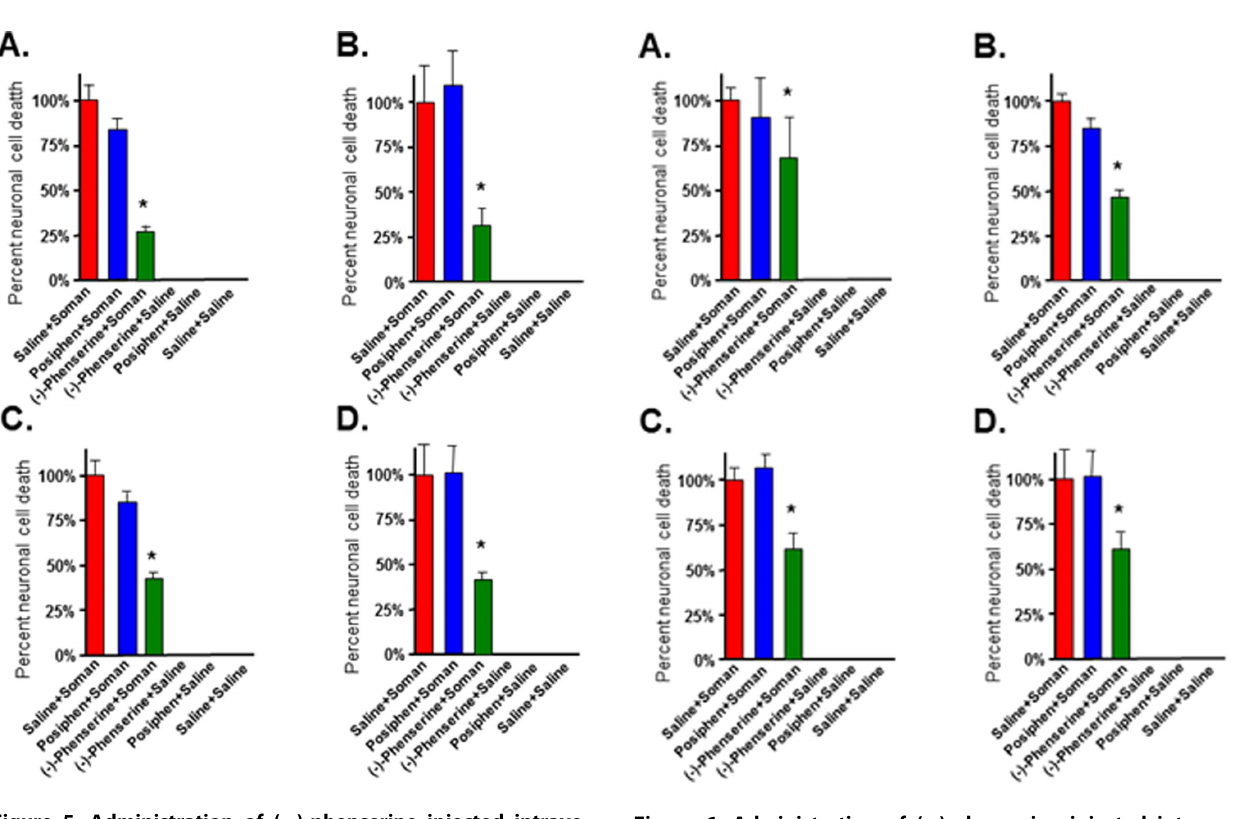
Figure 6. Administration of ( 2 )-phenserine injected intrave- nously 30 min after soman protects neurons against soman- induced neuronal cell death. Rats were post-treated with ( 2 )- phenserine, posiphen or saline thirty minutes after soman. Images from three representative fields were acquired for each of the four brain regions/animal. The number of fluorescein-positive neurons was counted by an investigator that was blinded to the treatment. The bar represents the average percent neuronal cell death 6 SD in the pirform cortex (A), hippocampus (B), basolateral amygdala (C), cingulate cortex (D). n=6/group. *p , 0.001 vs soman/saline by ANOVA + Tukey post hoc analysis.